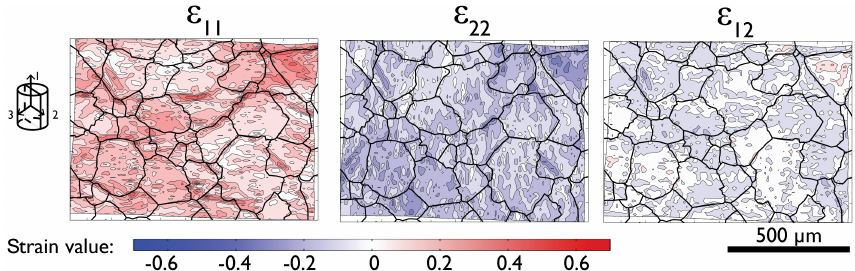
Figure 7. Strain maps for the three components of the 2-D strain tensor for a sample of Carrara marble deformed at T = 600 ◦ C and P c = 300MPa to 11% shortening strain at 3 × 10 − 5 s − 1 . The strain tensor was computed using the n -point technique with n = 9. The grain boundaries are overlaid on the strain maps. Positive strains correspond to